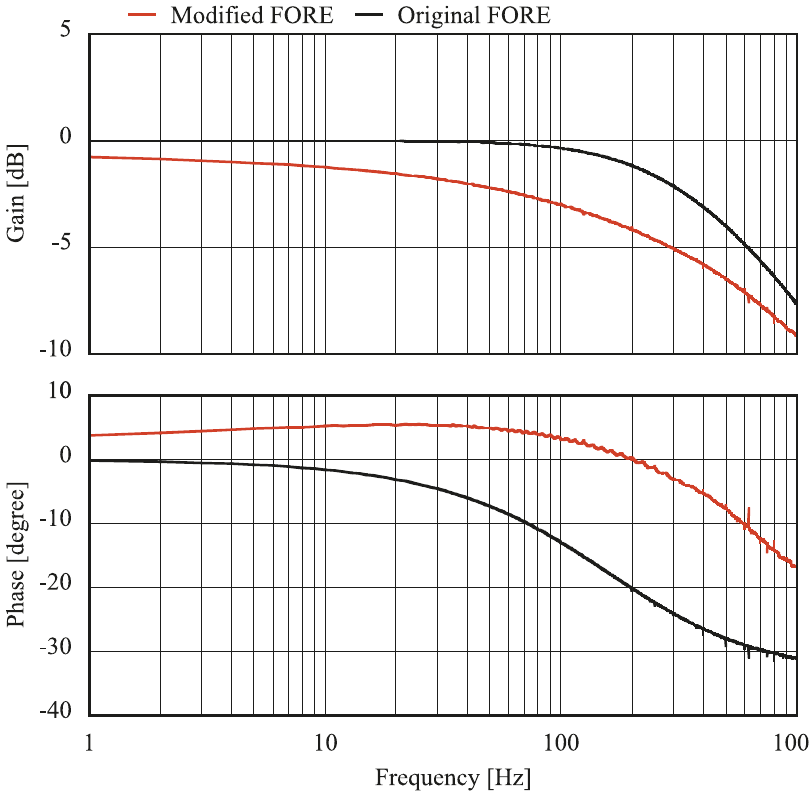
Figure 4. Simulated frequency response of both FOREs. The top represents a gain diagram. The bottom represents a phase diagram. Black line: original FORE; red line: modified FORE.